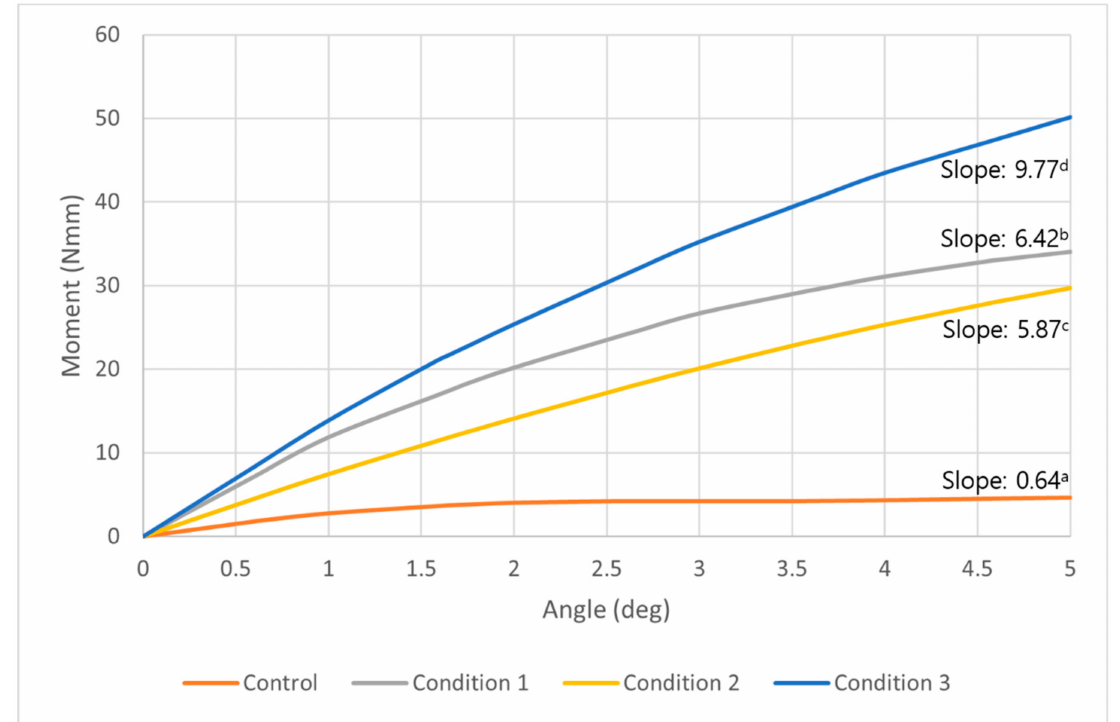
Figure 7. A graph of the moment at the middle of cortical bone required to unwind the orthodontic miniscrew in control (orange), condition 1 (gray), condition 2 (yellow), and condition 3 (blue). This graph shows a tendency similar to the graph of the overall moment in Figure 6. Three conditions all show constant increases as the degrees were raised to 5 degrees in counterclockwise rotational direction. The condition which showed the most increased moment was condition 3, followed by condition 1 and 2. a,b,c,d Different alphabets means statistically different slopes in control and each condition ( p <